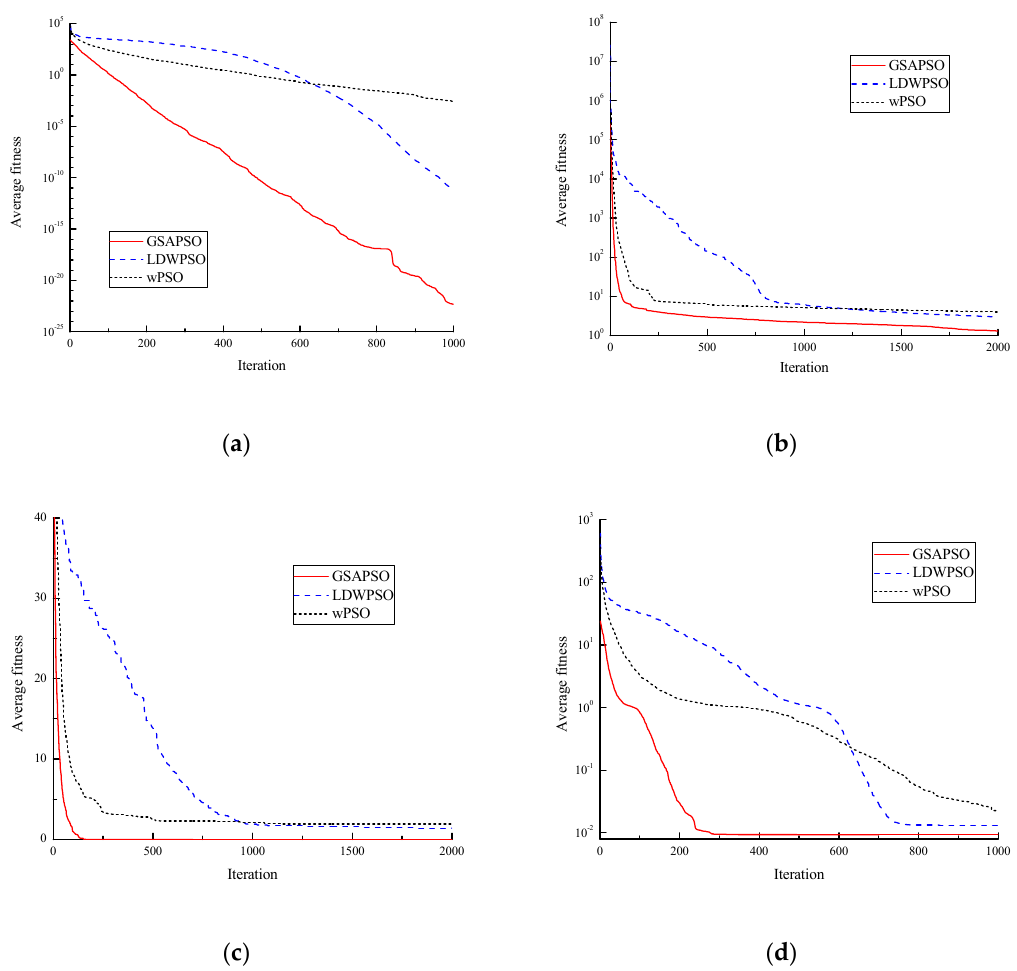
Figure 2. Function fitness curve: ( a ) Sphere fitness curve; ( b ) Rosenbrock fitness curve; ( c ) Rastrigin fitness curve; ( d ) Griewank fitness curve.